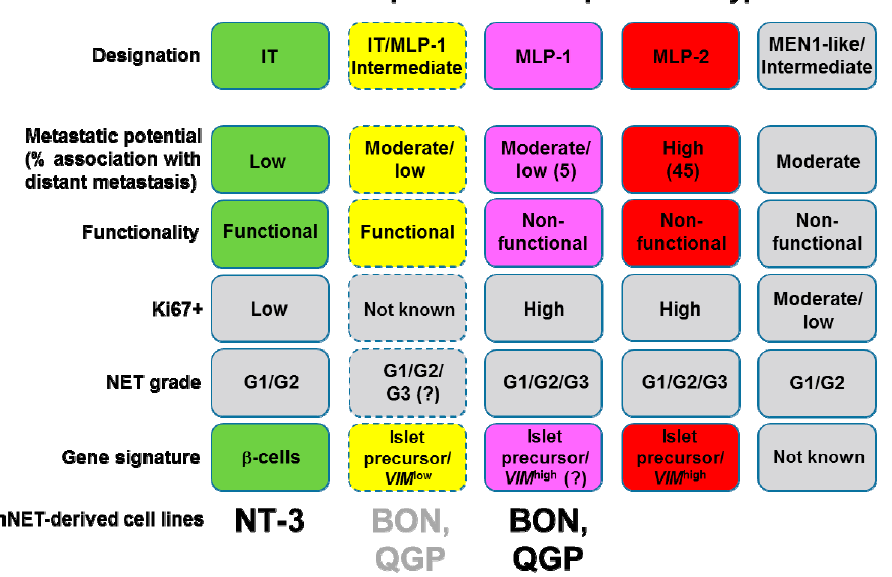
Figure 6. Cartoon showing allocation of NT-3, BON, and QGP cells to the transcriptional subtypes of pancreatic NET (panNET) described in [12]. Based on the data from phenotypic characterization and gene expression analyses, NT-3 cells can be classified as IT, while BON and QGP cells more closely resemble the MLP subtype. Due to the well-di ff erentiated epithelial phenotype, the expression of miRs with anti-EMT and anti-metastatic function, and the low or absent migratory activity in vitro, BON and QGP cells have been tentatively grouped into the MLP-1 sub-subtype of tumors. In case of EMT marker (i.e., VIM ), expression in the MLP-1 sub-subtype can be shown to be as high as in the MLP subtype (combining MLP-1 and MLP-2), then BON and QGP cells more likely belong to a still hypothetical subtype that combines features of both MLP and IT tumors (designated IT / MLP-1 Intermediate, yellow boxes with stippled lines). Tumors of this class are assumed to be still functional with respect to serotonin secretion of BON and SST secretion of QGP cells. Adapted from [12], modified. Within the MLP subtype of panNETs one half of primary tumor samples was poorly metastatic (termed MLP-1) while the other half (termed MLP-2) had high metastatic potential [12]. Our results on the low-to-absent migratory activity of BON and QGP cells in vitro is in line with high expression of the invasion suppressor E-cadherin in BON [41,55] and QGP cells, and low or undetectable expression of Vimentin, together predicting a low invasive / metastatic capacity. In orthotopic mouse models, wild-type BON cells showed a variable and comparatively low metastatic spread to the liver with metastases found in 0% [56], 12.5% [41], or ~50% [57] of transplanted mice, while equivalent data